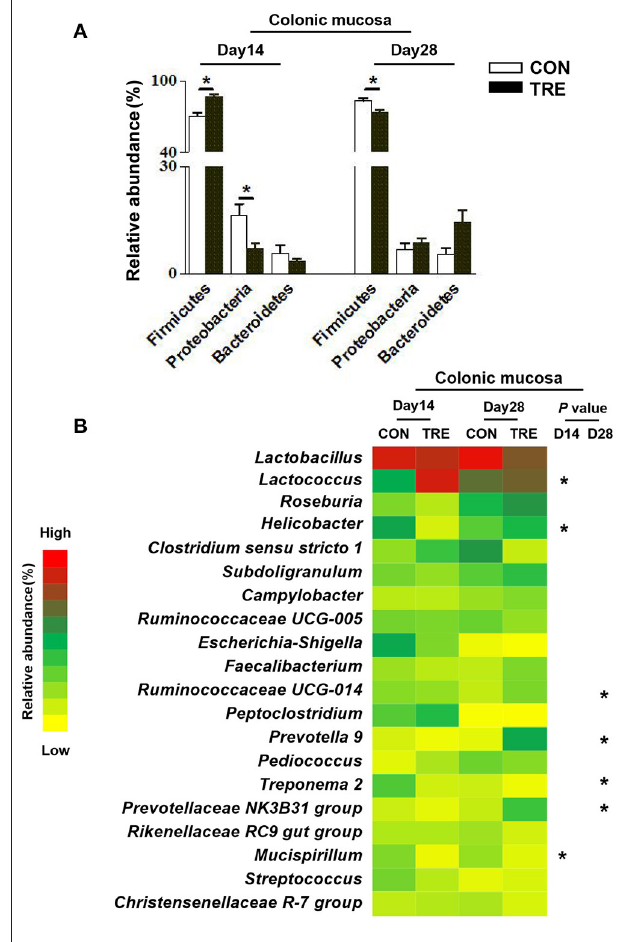
FIGURE 6 | Effect of protein restriction and succedent realimentation on bacterial composition of colonic mucosa in weaned piglets ( n = 6). (A) Alterations of dominant phyla in colonic mucosa on day 14 and 28. (B) Alterations of dominant genera in colonic mucosa on day 14 and 28. p < 0.05 were considered significant and markers (*) between groups on the same day. CON, control group; TRE, treatment